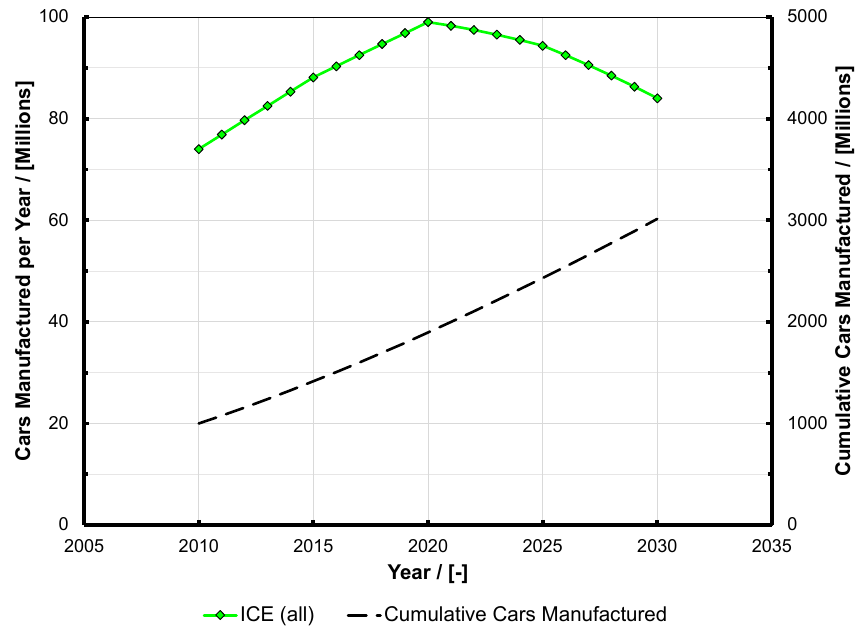
Figure 2. Data from Figure 1 reworked to show vehicles with an internal combustion engine fitted (i.e., pure ICE and hybrid vehicles). The values for cumulative cars built is the same as on Figure 1. Note that in 2030, nearly as many engines are predicted to be built as in 2014, and the value of 84 million engines per year still represents 2.66 engines per second. ICE: internal combustion engine.